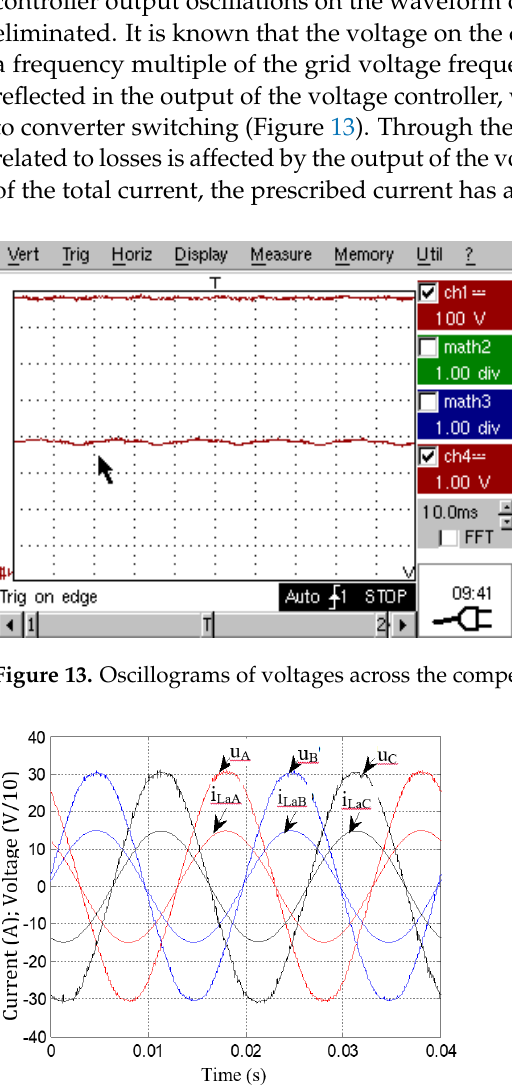
Figure 14. Balanced active voltages and currents (prescribed) on the load phases (provided by the graphical interface).